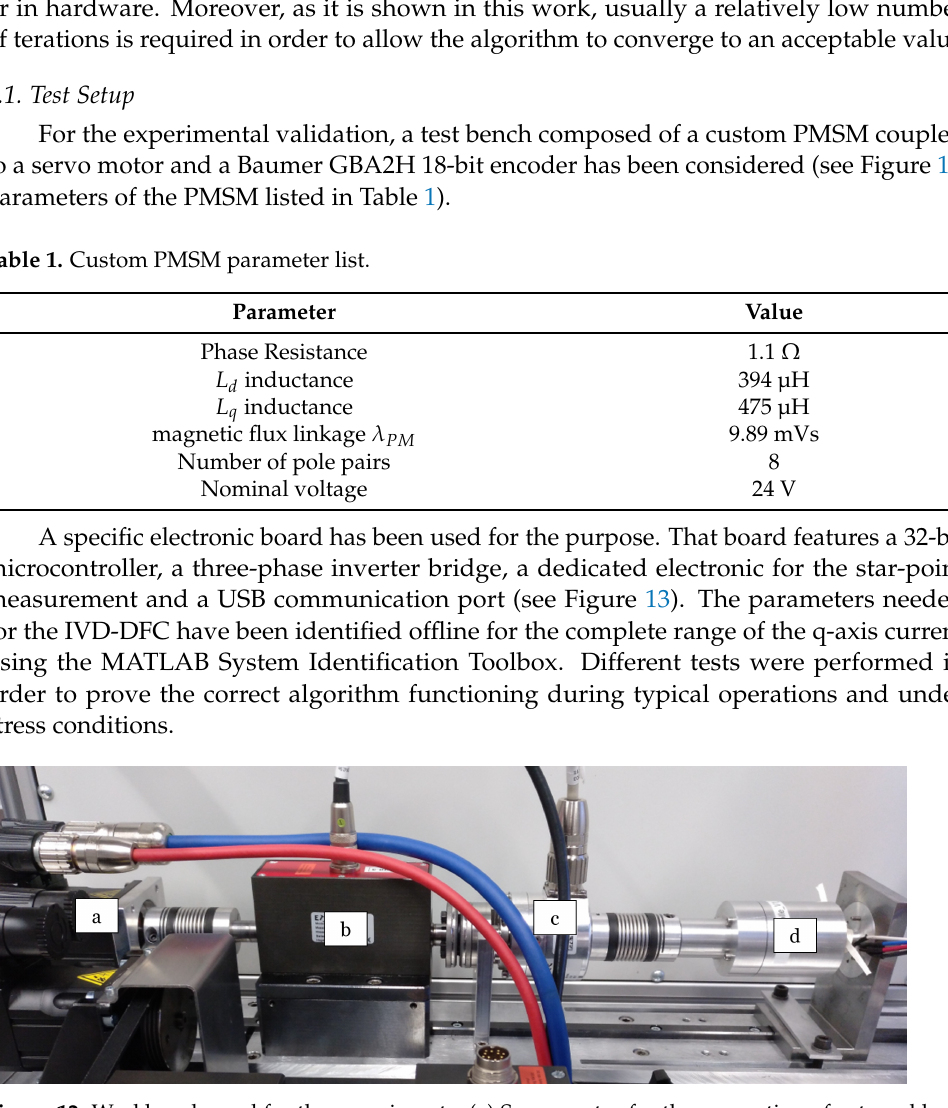
Figure 12. Workbench used for the experiments. ( a ) Servo motor for the generation of external load torque. ( b ) Load torque sensor. ( c ) Encoder. ( d ) PMSM under